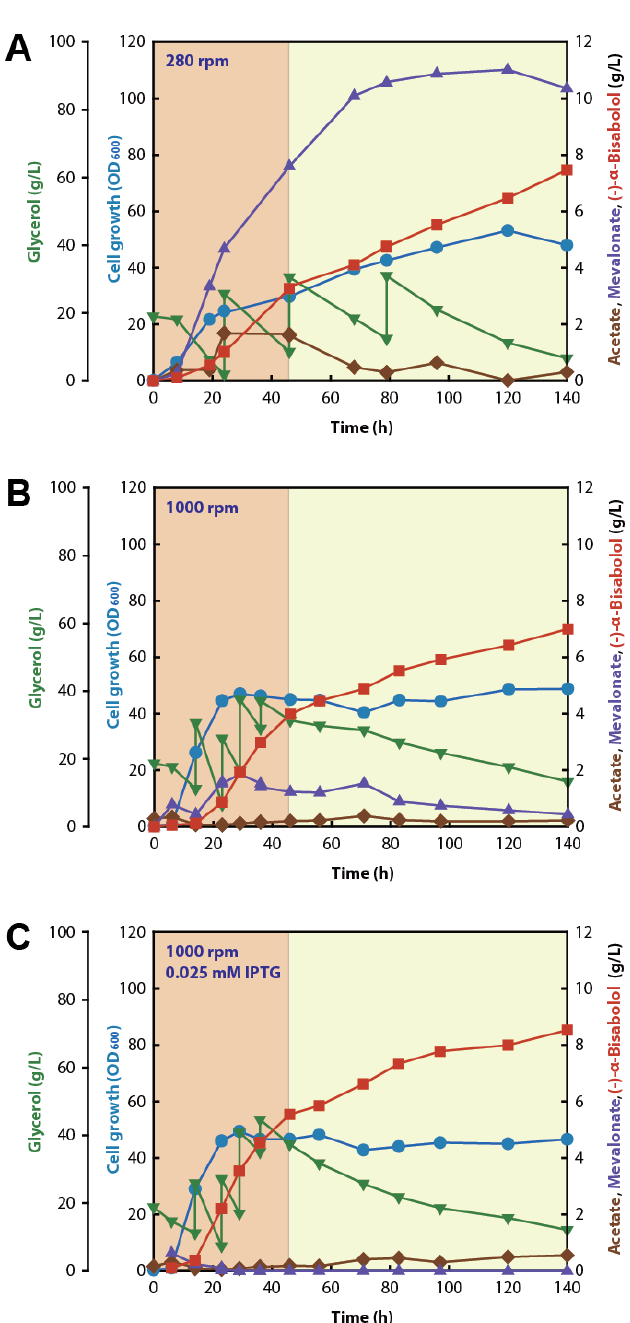
Figure 6. Fed-batch fermentation of the E. coli DH5 α harboring both pTSN-Bisa-Mm and pSSN12Didi-MrBBS-IspA plasmids. The fed-batch fermentation was performed in TB medium and 20% (v / v) of n -dodecane using two-phase culture at 30 ◦ C and pH 7.0. After depletion of